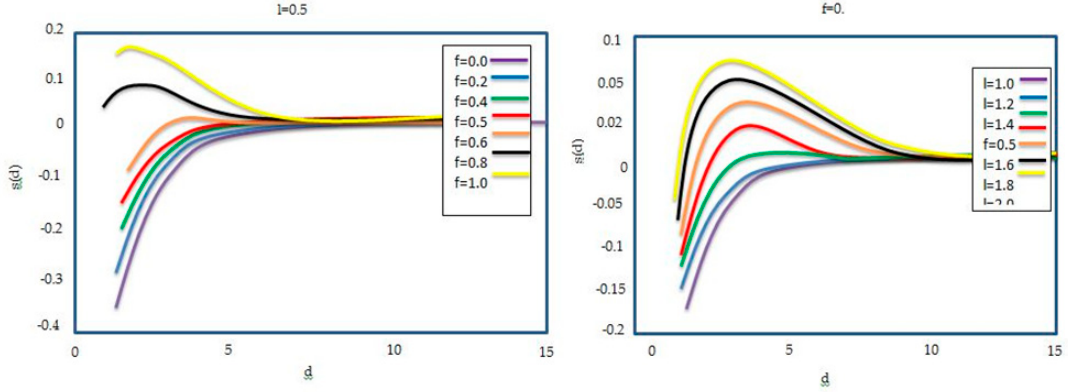
ff ectiveness of the value of (s) as it changes with one of the following l or f. Energies 2020 , 13 , x FOR PEER REVIEW Figure 5. Effectiveness of the value of (s) as it changes with one of the following l or f. Figure 5. E Figure 5. Effectiveness of the value of (s) as it changes with one of the following l or f.